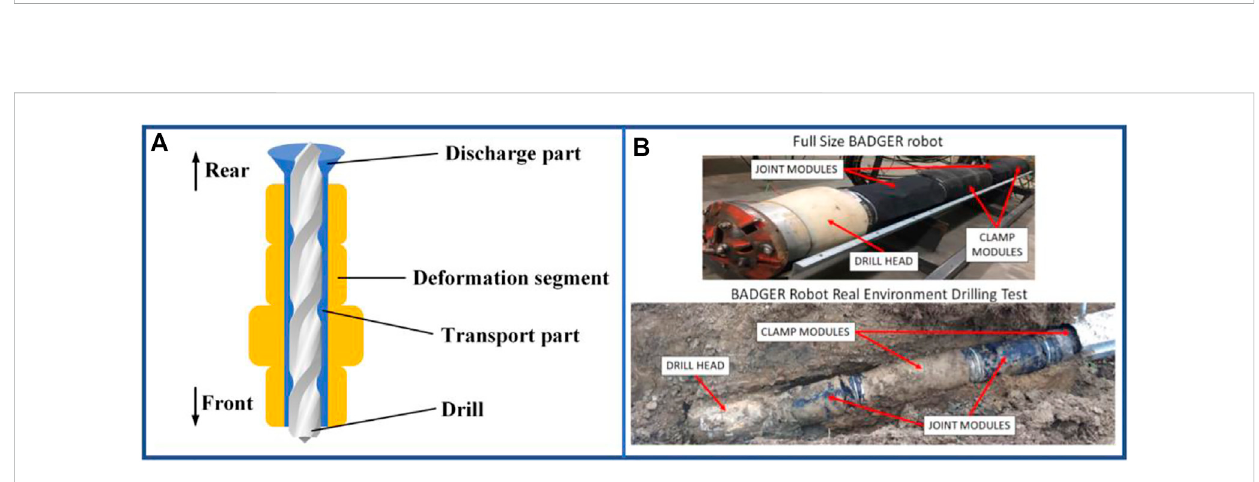
FIGURE 16 Examples of hybrid-driven multi-segment earthworm-inspired soft robot. (A) Diagram of underground explorer with drill and pneumatic actuator. (B) Robot BADGER hardware and its drilling test (Vartholomeos et al., 2021). Reproduced from Ref. (Vartholomeos et al., 2021). with permission.